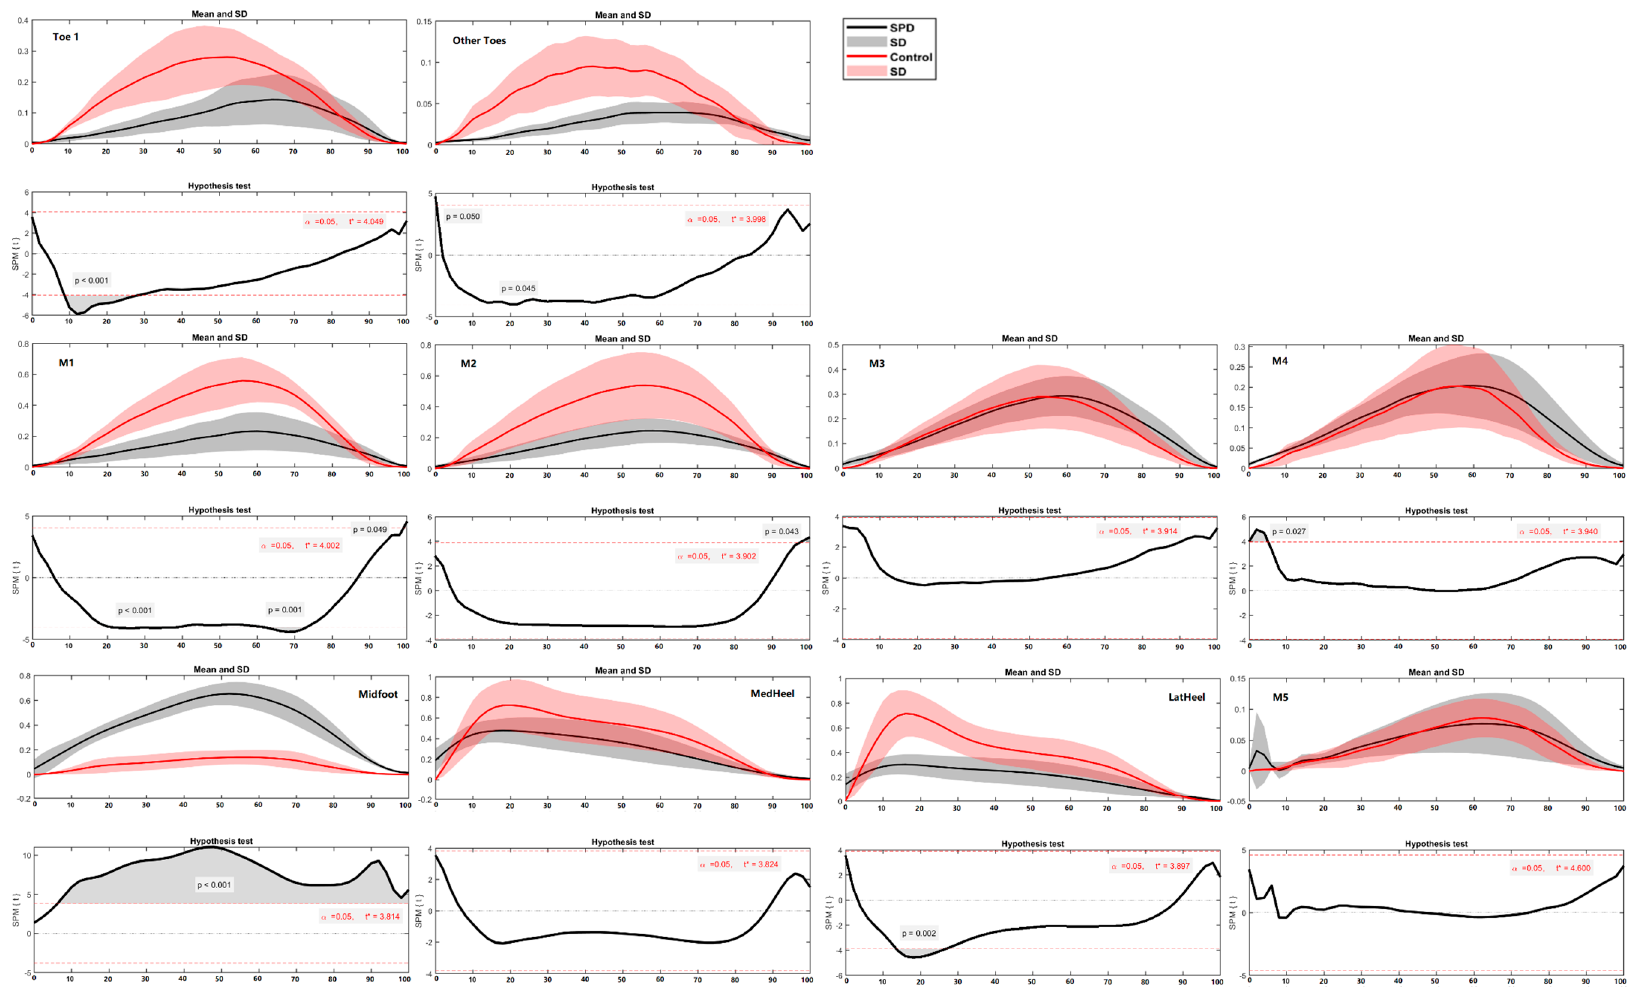
Figure 10. The regional plantar forces in the right foot during running in the SPD children and healthy controls with highlighted statistics.